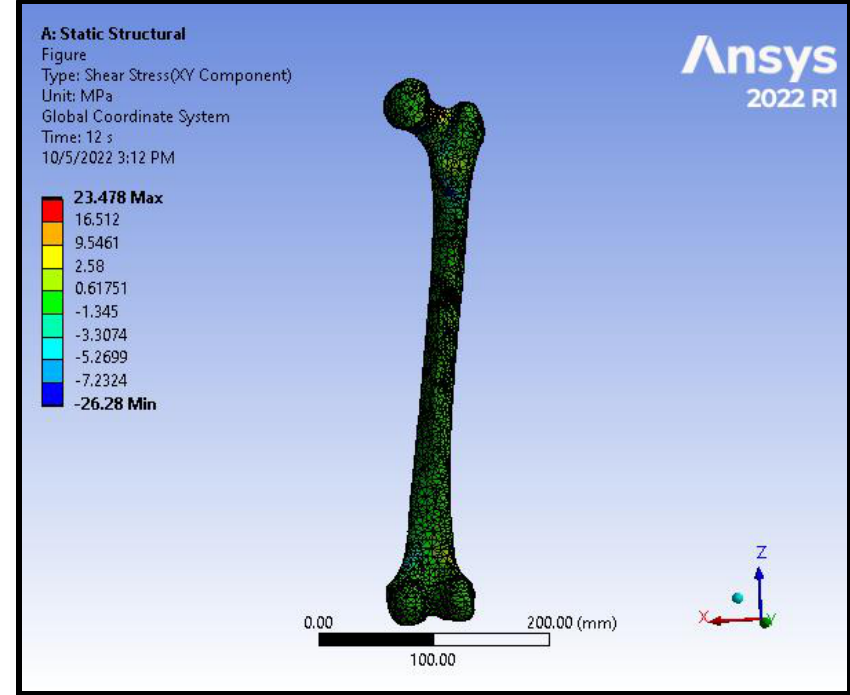
Figure 9. Shear stress distribution on the femoral model in an intracapsular fracture under axial compression and torsion scenario.